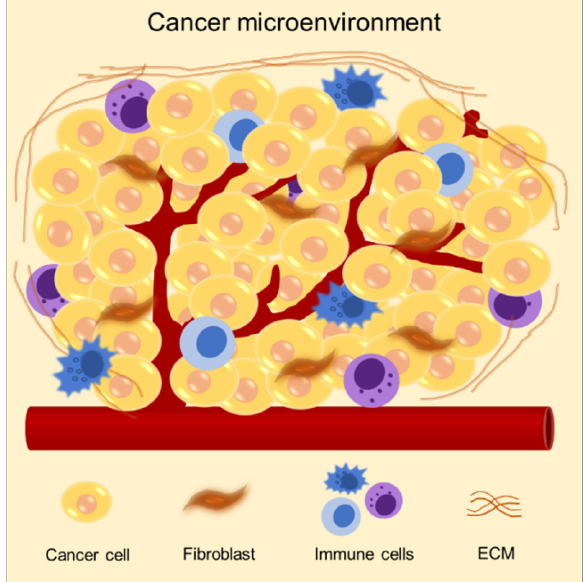
Figure 2. Schematic of characteristics of the cancer microenvironment composed of diverse cell types, including heterogeneous cancer cells, stromal cells such as fibroblast and endothelial cells, immune cells, and a dense extracellular matrix.